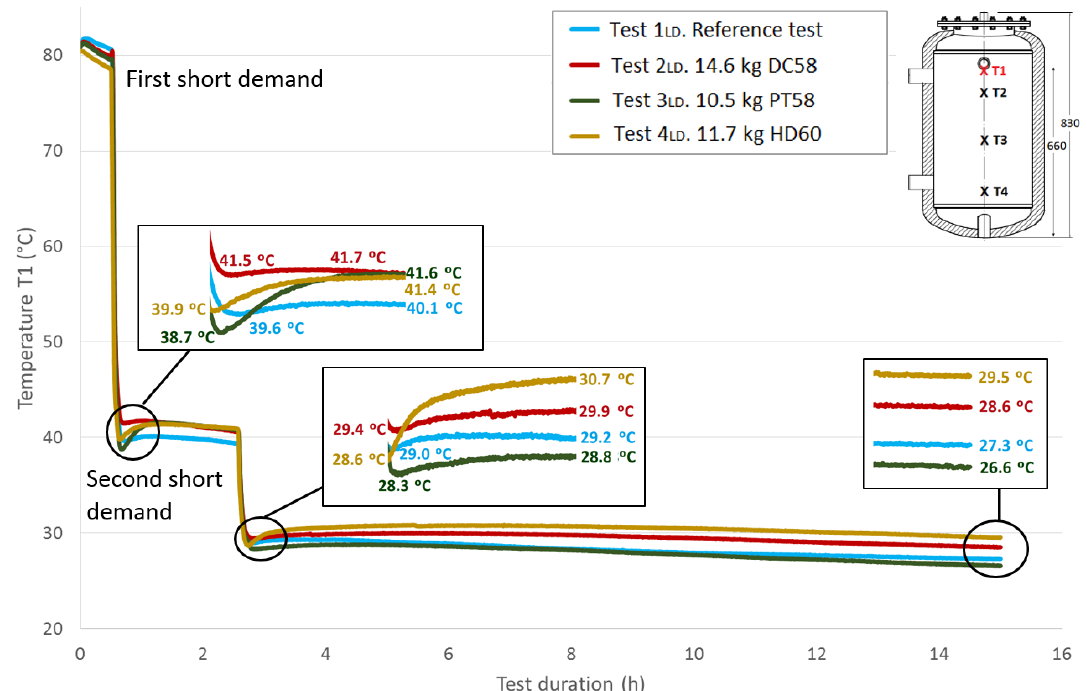
Figure 12. Top height water temperature ( T 1) inside the tank during the two shorts demands experiment. (dimensions are in mm).